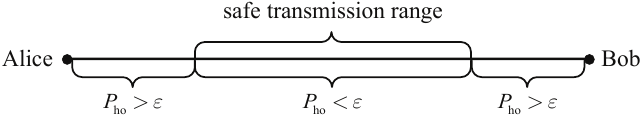
Figure 2. Safe transmission range.